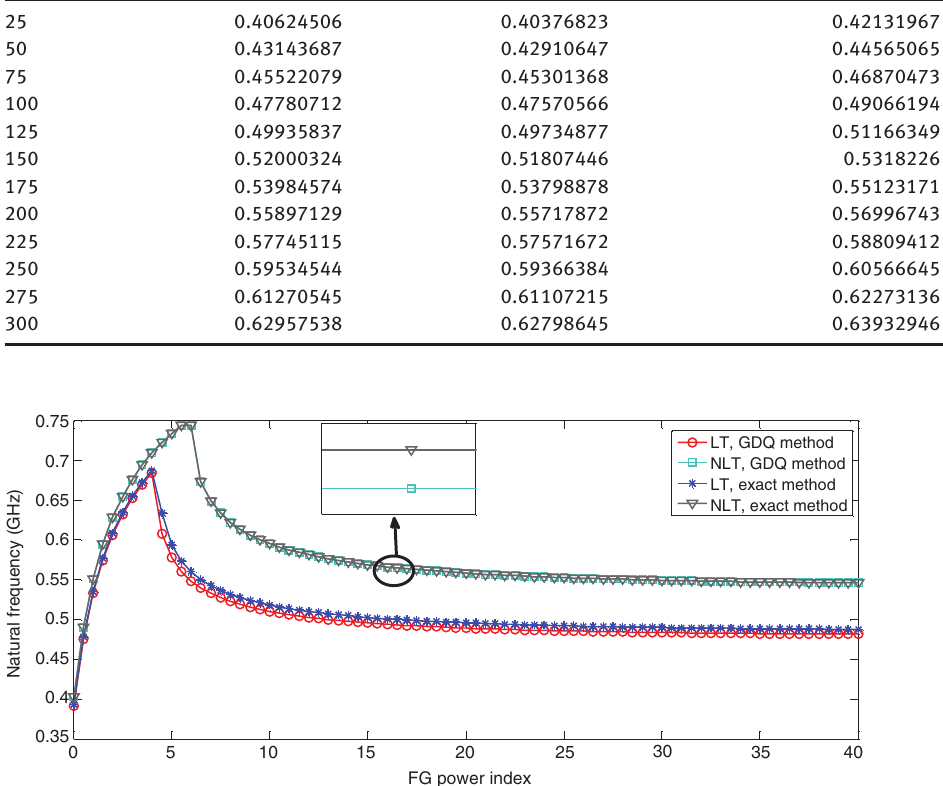
= 14 μ m, l = l /2, n = 1, m c m